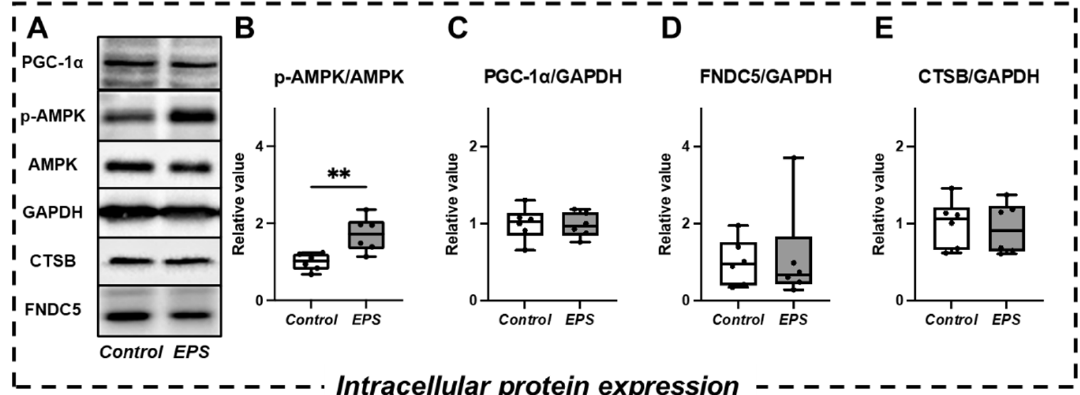
Figure 2. Comparison of intracellular protein expression in 3D-EM ( A ). Western blot analyses with anti-phosphorylated AMPK ( B ), PGC-1 α ( C ), FNDC5 ( D ), and CTSB ( E ) were performed ( n = 6). All protein expression levels were normalized to the GAPDH level. Proteins are expressed relative to the value of the control protein levels (relative value). Values are presented as the median (horizontal line in the box), range between the 25th and 75th quartiles (box), and maximum and minimum values (whisker). At least two independent experiments were performed. ** Significant difference between groups ( p < 0.01).